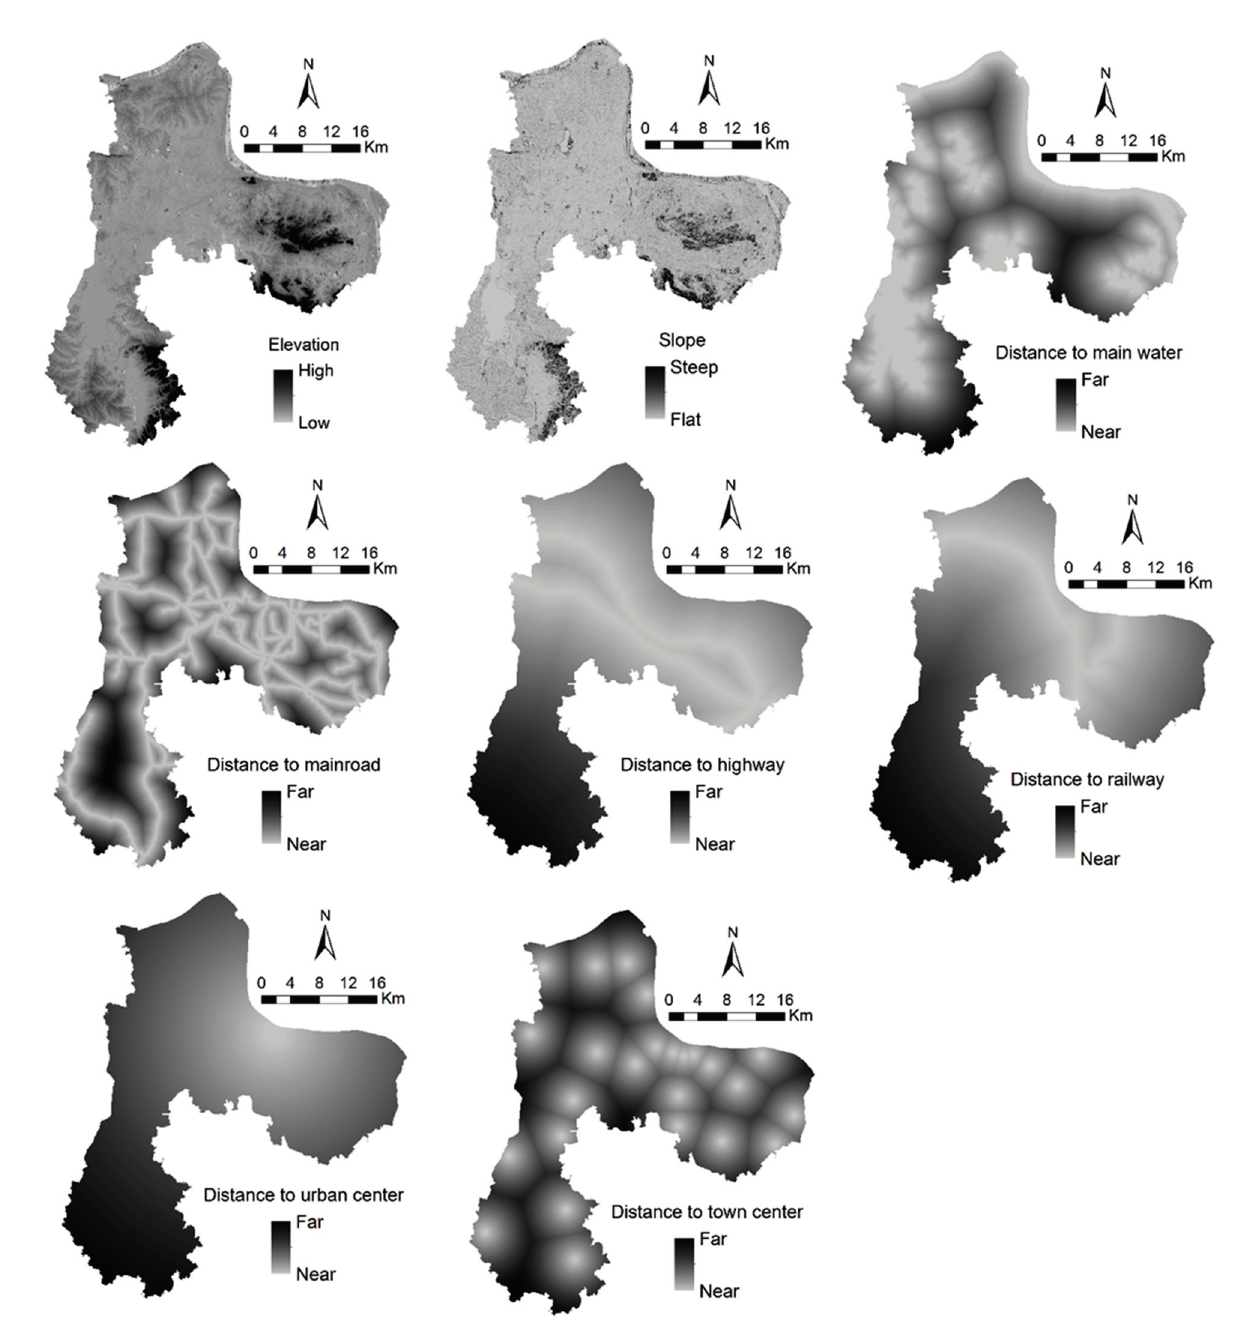
Figure 4. Maps of driving factors of land use and land cover change in the study